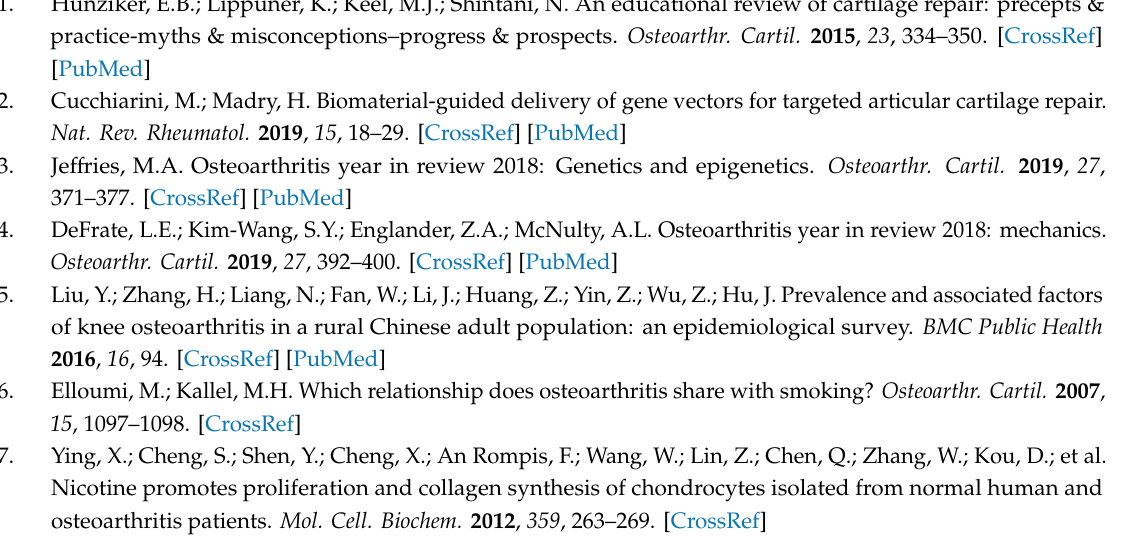
Table S1: In vitro studies of e ff ects of nicotine on chondrogenesis and osteogenesis of medicinal signaling cells, Table S2: In vitro studies of e ff ects of smokers tobacco extract (STE) on osteoblast di ff erentiation, Table S3: In vitro studies of e ff ects of nicotine on articular chondrocytes, Table S4: Animal study of e ff ect of nicotine on cartilage defect repair and OA, Table S5: E ff ects of prenatal nicotine exposure of animals knee cartilage development and OA susceptibility in o ff